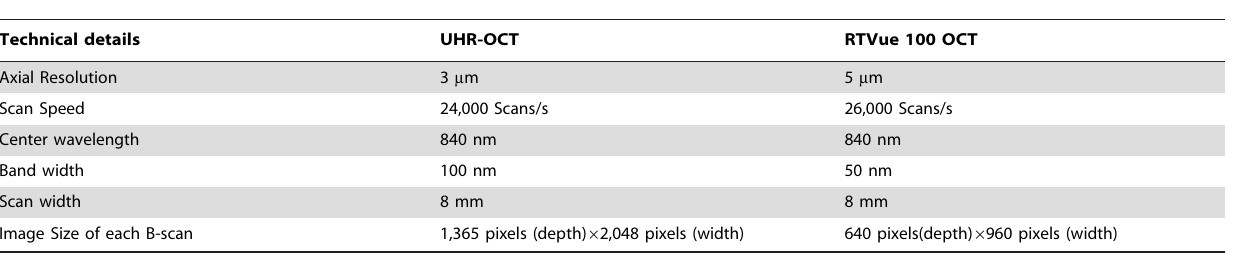
Table 1. Configuration of the two OCT instruments.